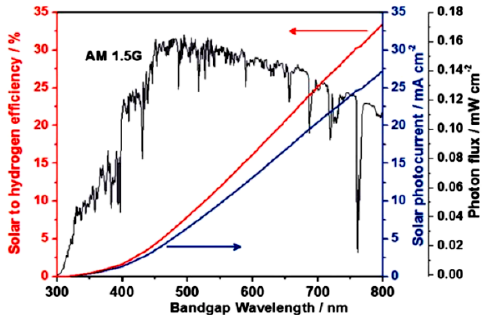
Figure 1. Dependence of theoretical solar-to-hydrogen (STH) efficiency and solar photocurrent density of photoelectrodes on their bandgap absorption edges. Reprinted with permission from ref. [5]. Copyright 2013. The Royal Society of Chemistry.